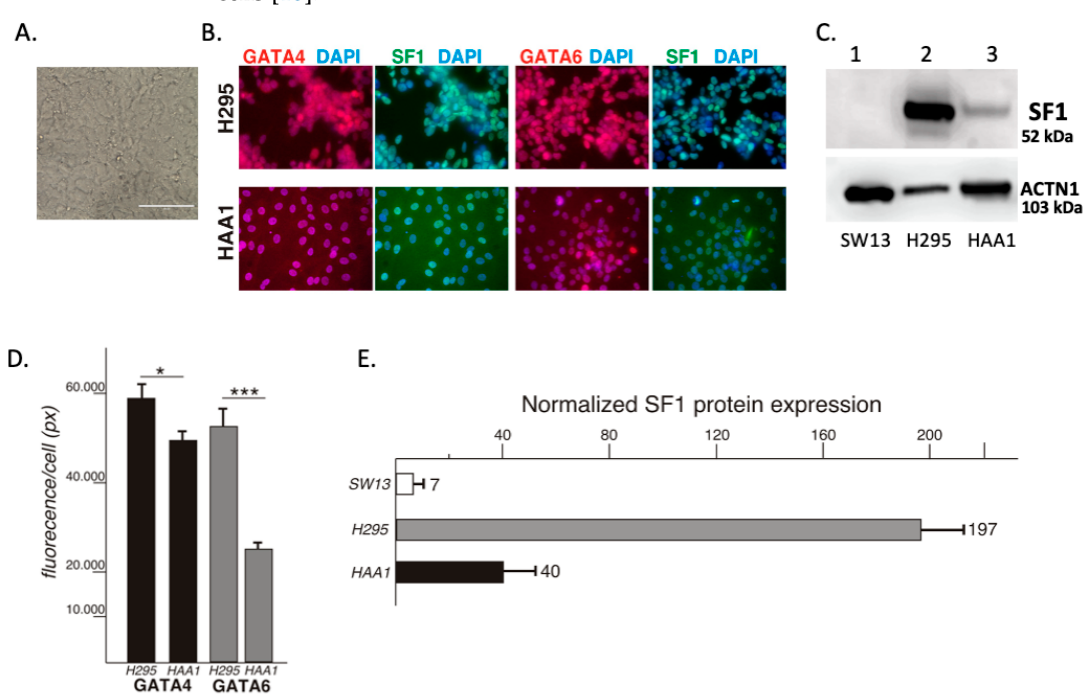
NR5A1/SF1 (top panel) and ACTIN1 (bottom panel); L1. SW13 adrenal carcinoma cells (these